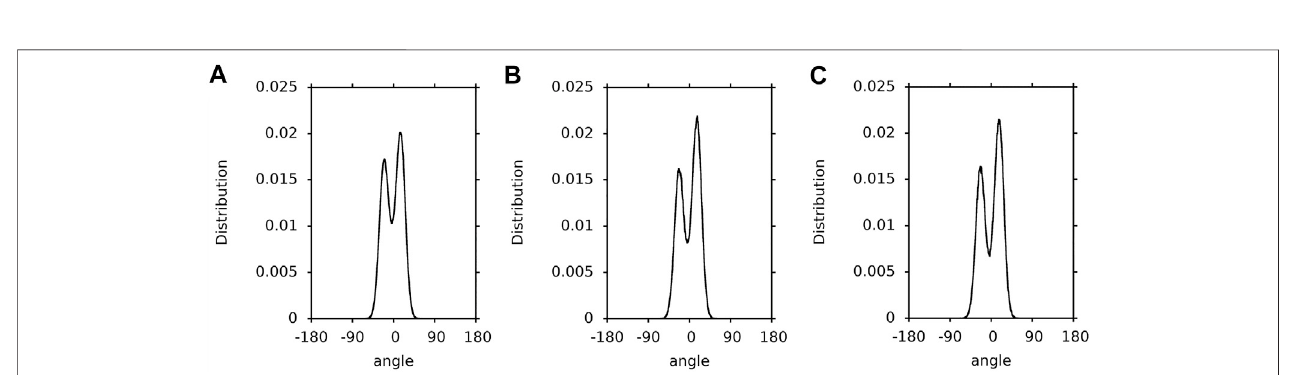
FIGURE 5 | Population distributions of the zeaxanthin ß -ring torsions. (A) in the PC-ZEA bilayer; (B) in water; (C) in vacuum.